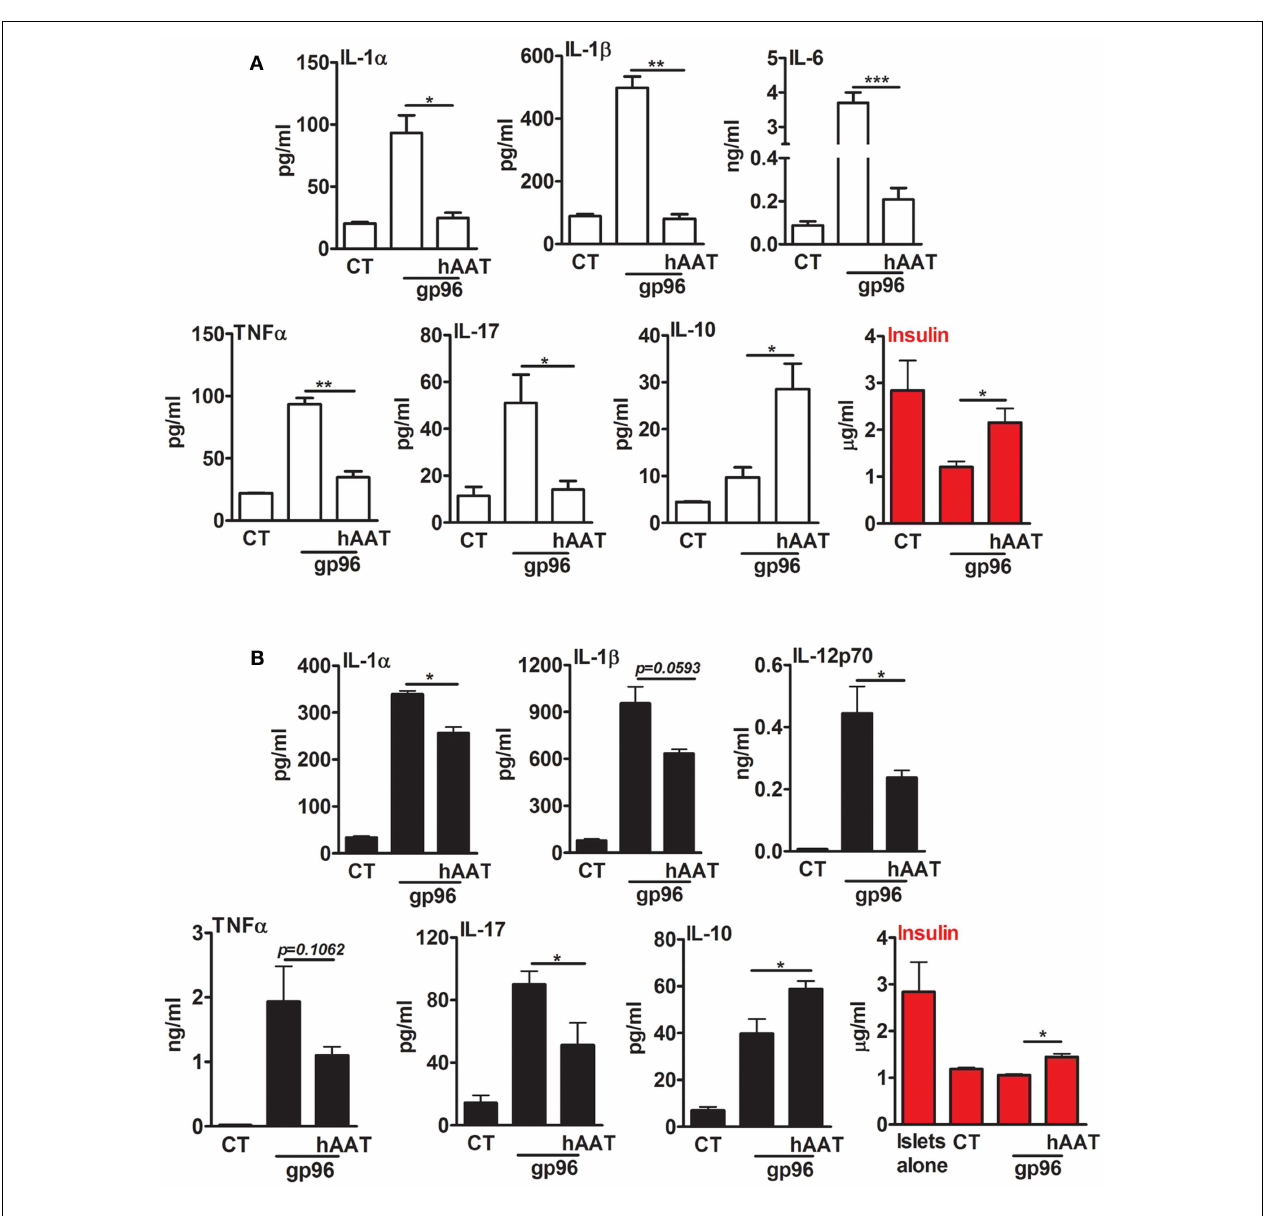
(50pM) for 48h. Inflammatory mediators and insulin levels were determined by multiplex ELISA and standard ELISA, respectively. CT, untreated cells. (A) Islets, (B) co-culture; representative results from four independent experiments. Mean ± SEM, * p < 0.05, ** p < 0.01, *** p <